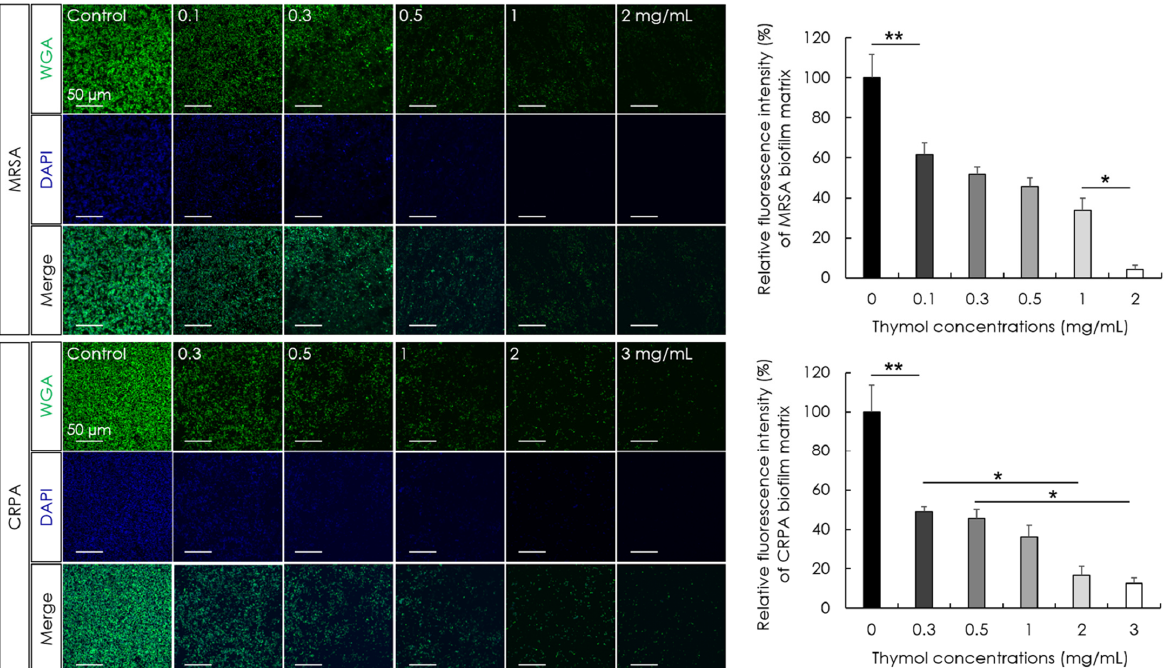
Figure 5. The activity of thymol against the extracellular matrix of biofilms produced by methicillin- resistant Staphylococcus aureus (MRSA) and ciprofloxacin-resistant Pseudomonas aeruginosa (CRPA).